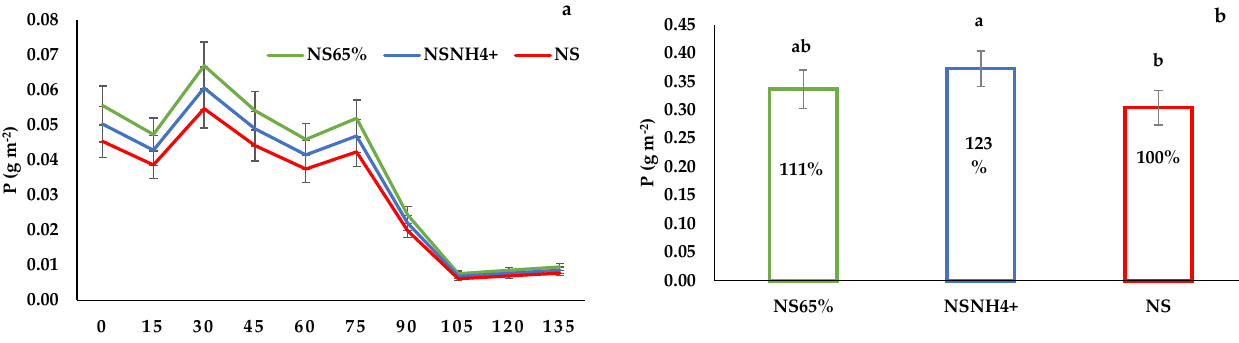
Figure 2. ( a ) Evolution of P leaching during the cultivation, ( b ) Total amount of P leached by the tomato crop, with the percentage of contamination reduction of the fertigation strategies assayed compared to standard fertigation. The columns show the mean values, and the bars the standard deviation of each treatment ( n = 12) at the end of the trial. Different letters indicate the significant differences among treatments at the p < 0.05 level, based on the LSD test.